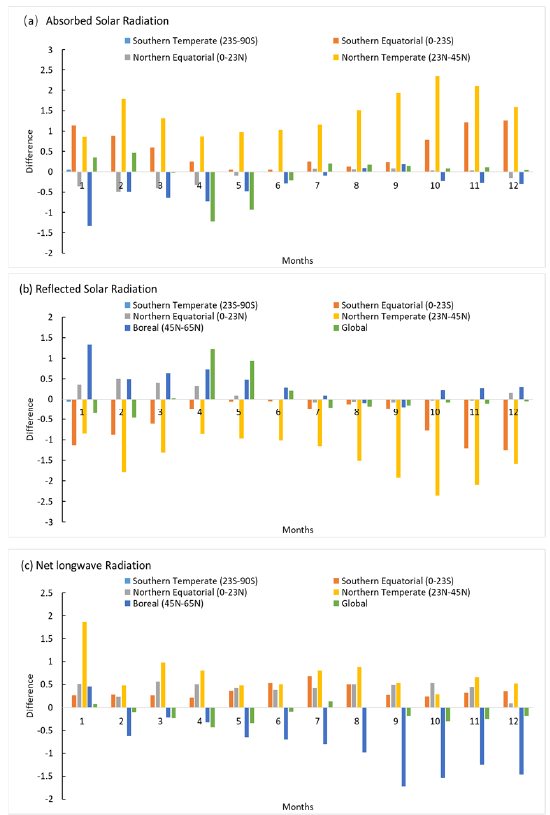
Figure 4. The zonal distribution of differences in ( a ) ASR, ( b ) RSR, and ( c ) NLR between ESACCI and CLM_LS (W/m 2 ).